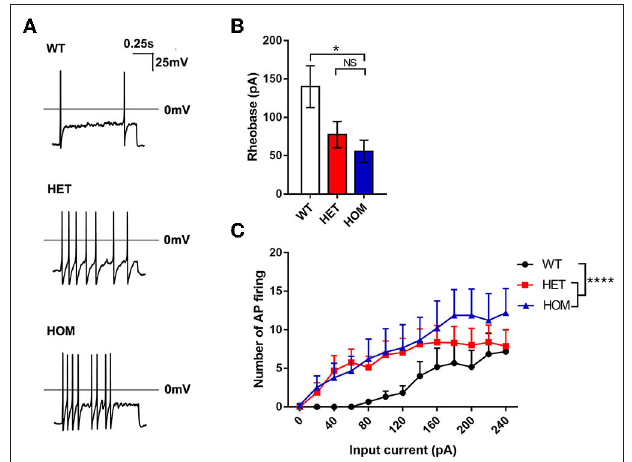
FIGURE 2 | The R222S mutation increased the excitability of DRG neurons in electrophysiological examinations. (A) Action potential traces were recorded from a representative WT, HET, and HOM mouse DRG neuron, respectively. (B) The rheobases among 3 groups. (C) The number of action potential firing elicited by the depolarizing current steps from 0 to 240pA in 20-pA increments in DRG neurons. Data were presented as the mean ± SEM. Significance was tested with one-way ANOVA followed by the Dunnett’s multiple comparisons test (B) or two-way ANOVA followed by the Tukey’s multiple comparisons test (C) . * p < 0.05 and **** p < 0.0001 vs. WT mice. NS, no significance; WT, wild-type ( Scn11a + / + mice); HET, heterozygote ( Scn11a + / R222S mice); HOM, homozygote ( Scn11a R222S / R222S mice).